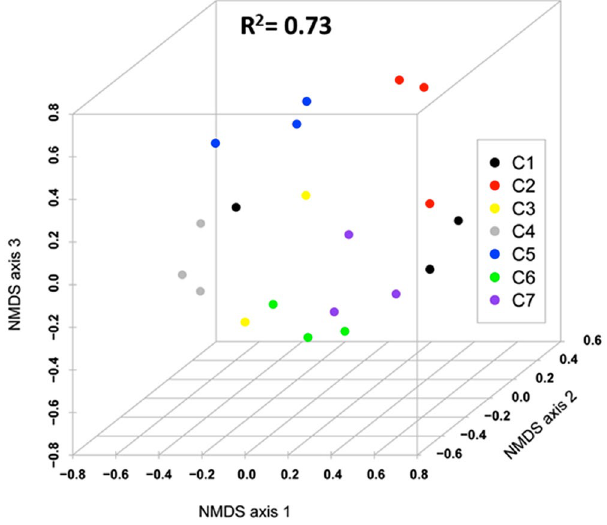
Figure 4. nMDS (nonmetric multidimensional scaling) plot of the entire bacterial community in each intestine sample. OTUs were determined based on 97% read similarities. Samples from the different intestine sections (esophagus, middle, cloaca) of each bird, clustered together. C1–C7 indicate the different cormorant individuals and are marked in different colors (three samples from an individual cormorant) (R 2 = 0.73, stress value =